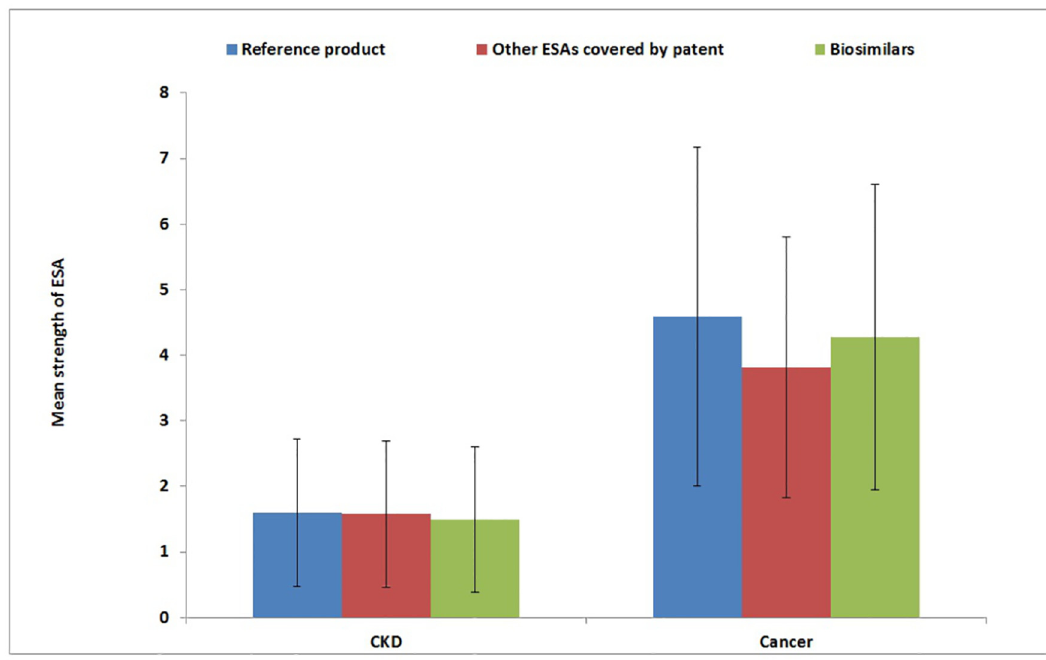
Fig 4. Mean strength of ESA treatment during the whole follow-up, stratified by indication for use and type of ESA. CKD = Chronic kidney disease; ESAs = Erythropoiesis-stimulating